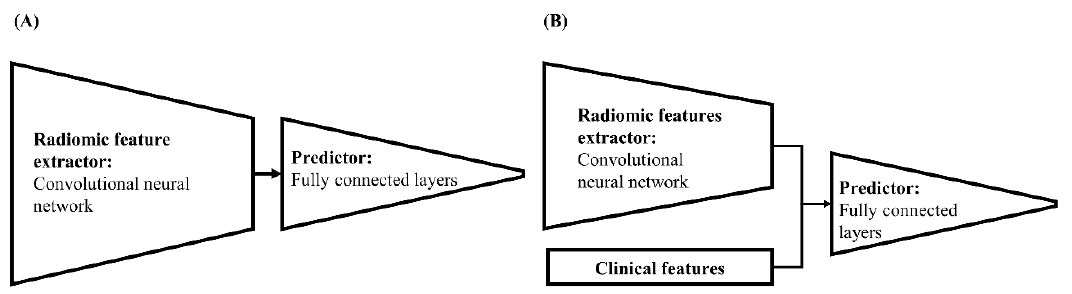
Figure 3. Diagrams of ( A ) the model using radiomic features and ( B ) the model using both clinical and radiomic features. Table 5. Layers and parameters of the prediction model employing both the clinical and radiomic features (M CR ).